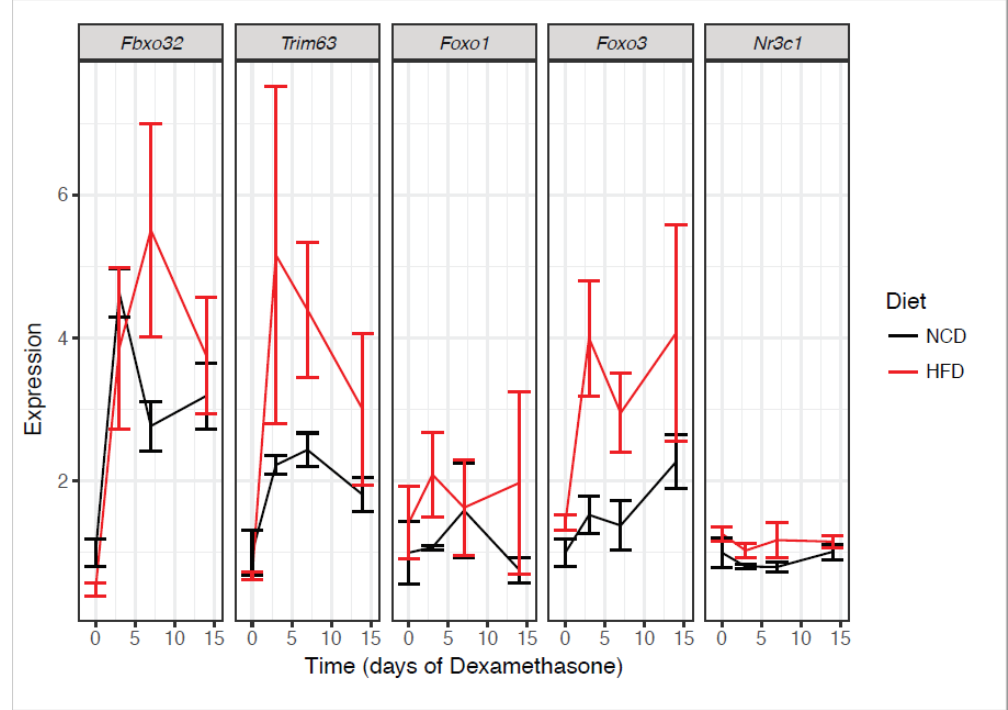
Figure 3. Obesity enhances dexamethasone-induced muscle degradation transcripts. Atrogene expression in NCD or HFD mice treated with dexamethasone for the indicated time points and euthanized ad libitum. mRNA was extracted and quantified from quadriceps muscles. n = 6–8 per group.